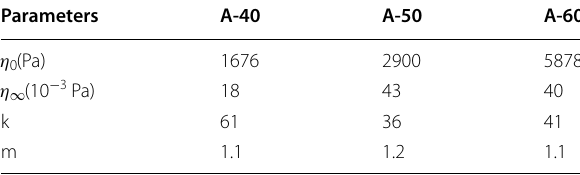
Table 4 Fitting parameters of Cross